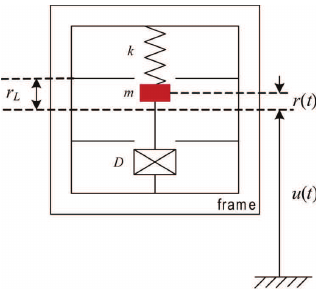
Figure 5: Link-segment and free-body model [13].